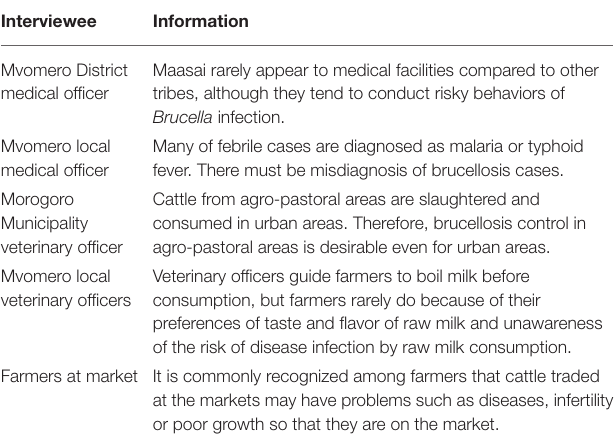
TABLE 3 | Key information obtained from key informant